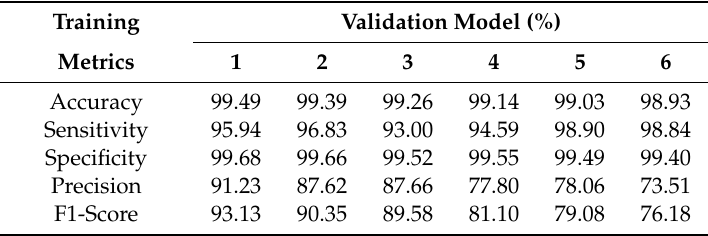
Table 3. The performance evaluation of DL models in the training phase.